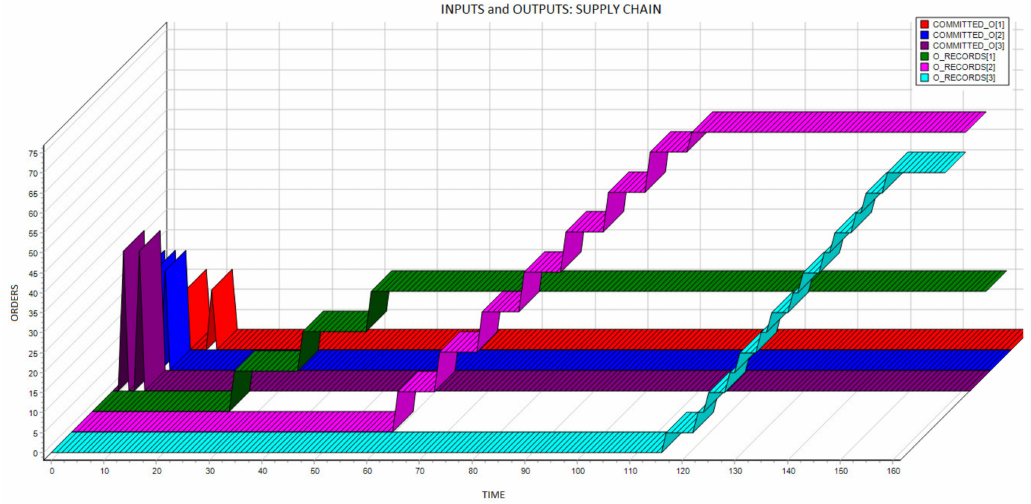
Figure 8. Validation test with oversized demand. Source: own elaboration. Evolution